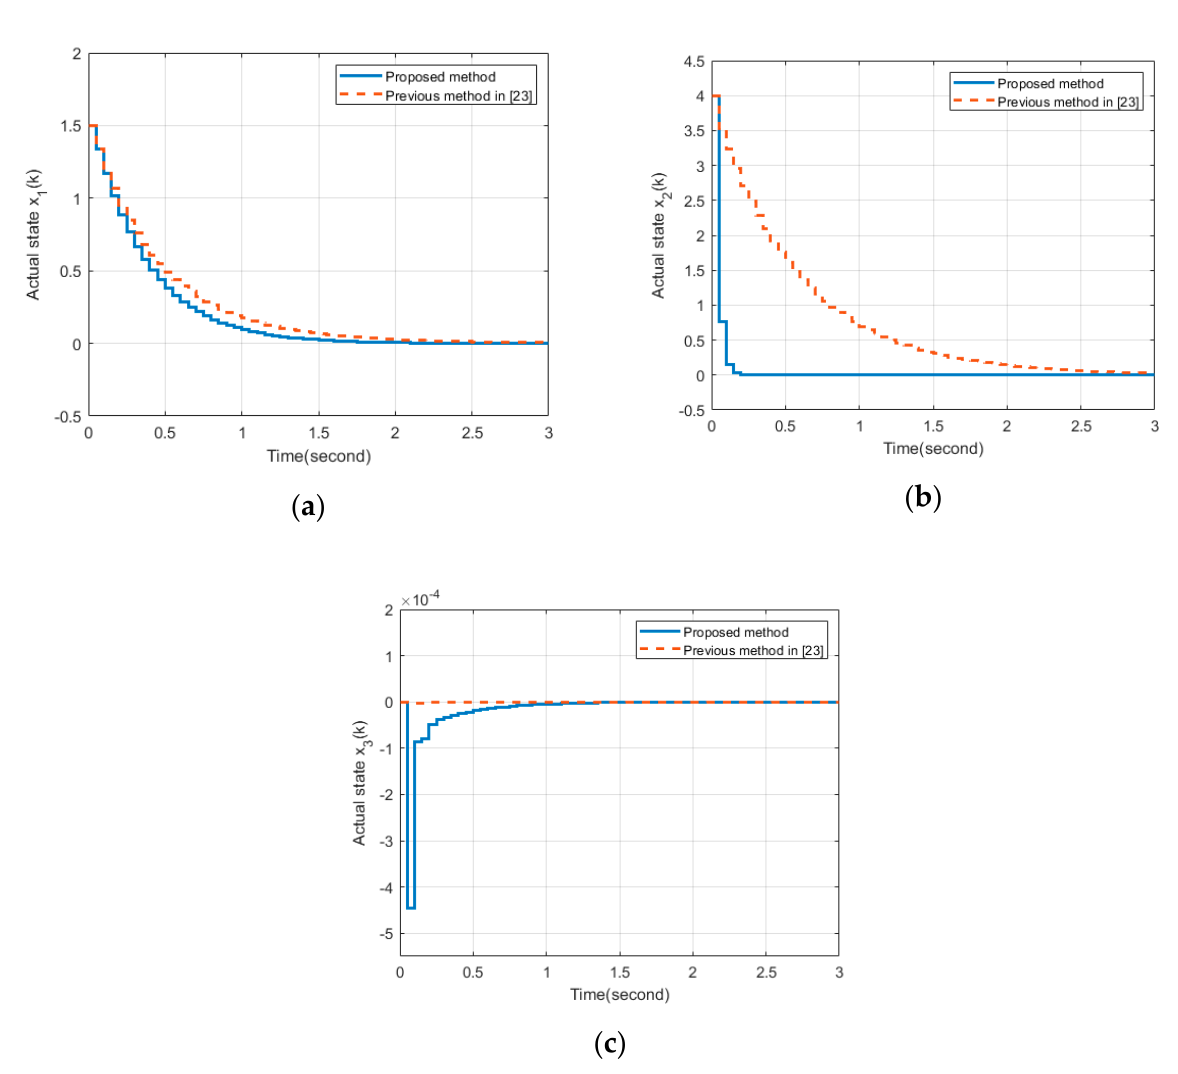
( ) x k ; ( c ) The comparisons of 2